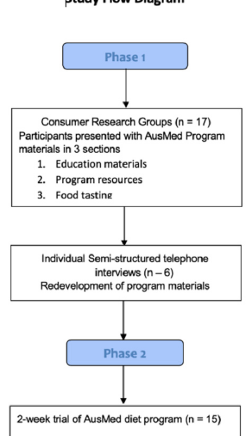
Figure 1. Flow chart of the study